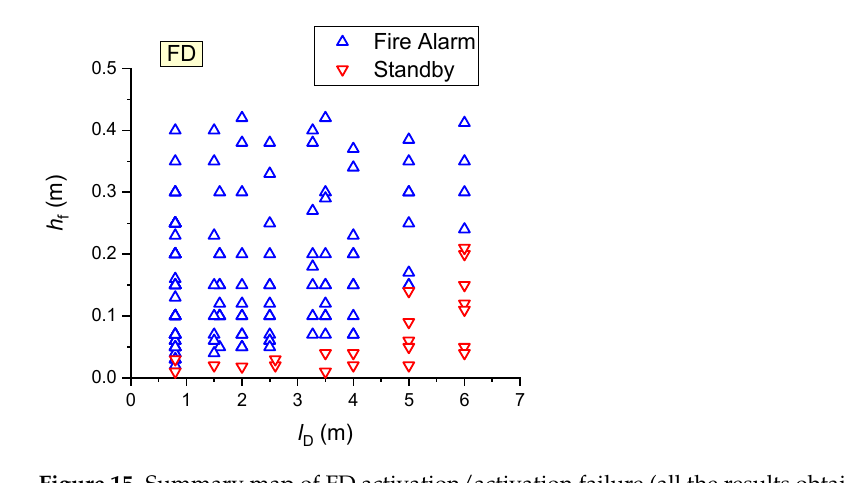
Figure 14. FD activation time during wood combustion versus flame height ( a ), height of detector position ( b ) and distance of detectors from the fire ( c ).